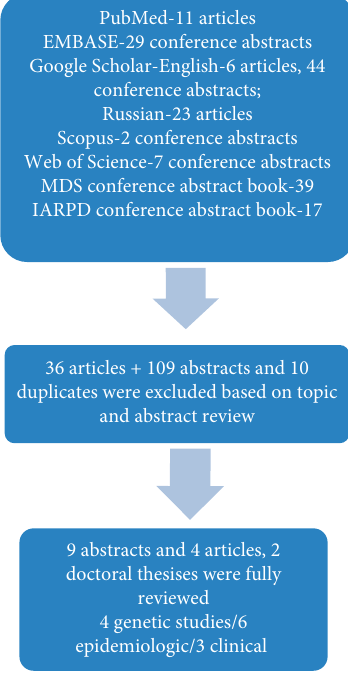
Figure 2: PRISMA flow